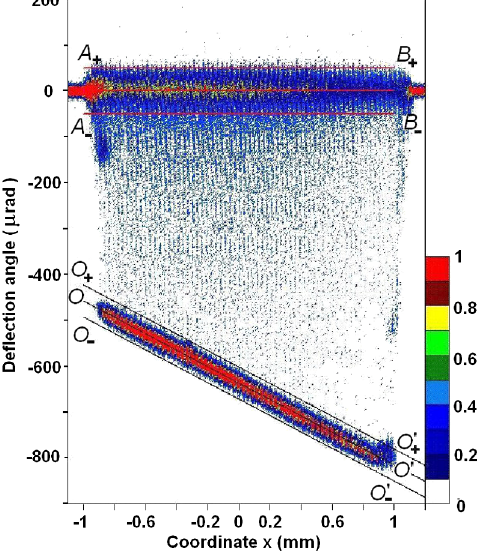
FIG. 4. Beam intensity recorded by the microstrip detectors as a function of horizontal coordinate x and horizontal deflection angle. The maximum of the intensity distribution is normalized to 1 (color band). The area between lines A þ B þ and A − B − corresponds to nonchanneled particles, which pass through the crystal after scattering. Because of the difference of the paths of nonchanneled particles, the particle density decreases from left to right along A (cid:2) B (cid:2) lines due to multiple Coulomb scattering. The line OO 0 corresponds to the center of the distribution of channeled particles which passed along the full crystal length. The particles between A − B − and O þ O 0 þ correspond to the dechanneled beam fraction. The beam momentum is 400 GeV =c . Between the two regions of emerging channeled and nonchanneled events, a region of dechanneled events is located, where particles entering the crystal were captured into the channeling regime but later dechanneled before